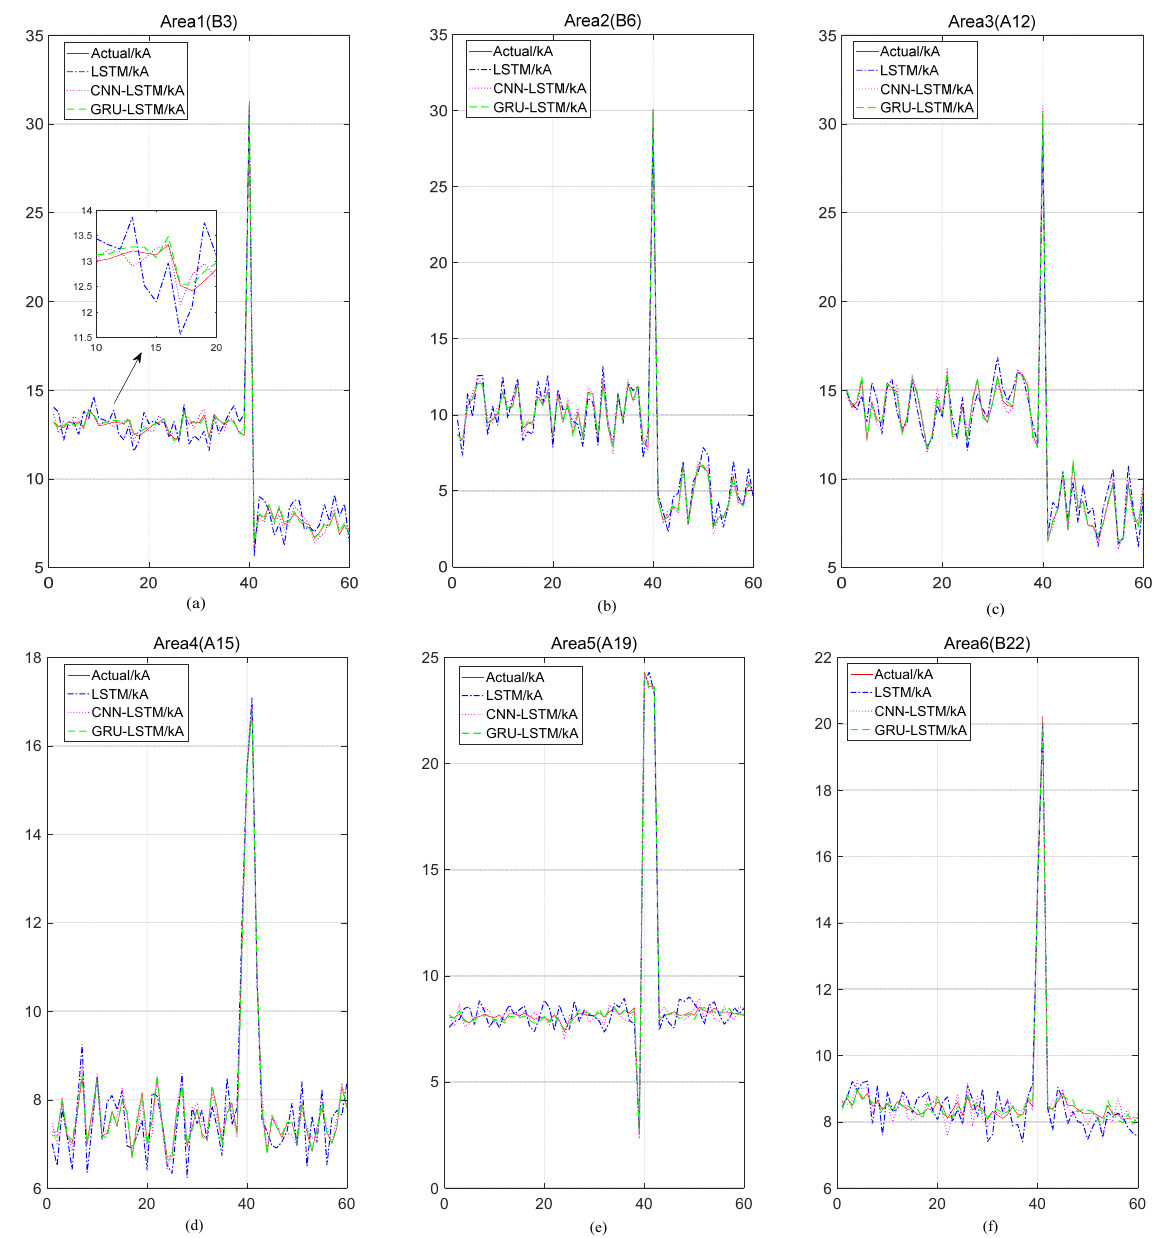
Figure 9. Prediction diagram of fluctuating current in 6 areas of aluminum reduction cell.